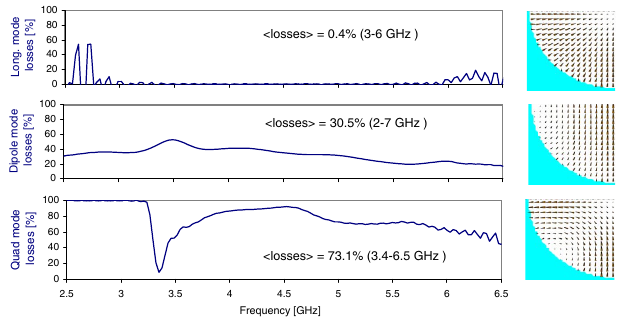
FIG. 12. (Color) Losses for different modes in an absorber. The insets show electric force lines for each mode.